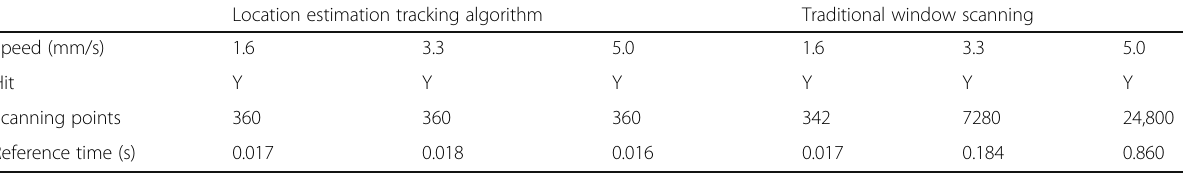
Table 2 Experimental comparison of position prediction tracking algorithm Location estimation tracking